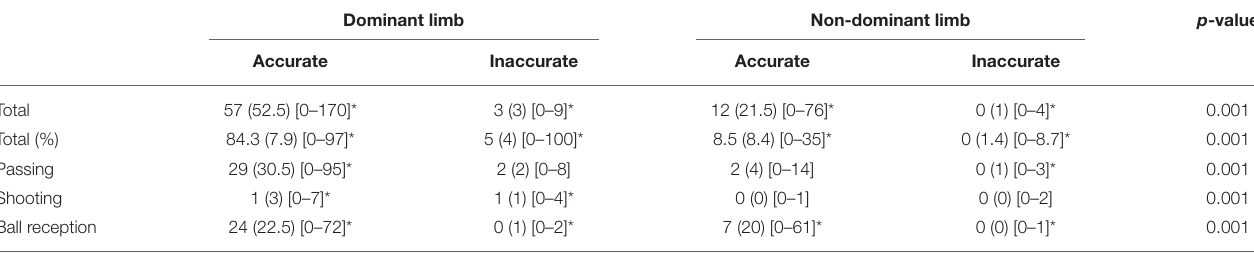
TABLE 1 | Median, interquartile range, and extreme values regarding the frequency counts (i.e., absolute number; a.u.) of technical parameters performed using dominant and non-dominant limb. Dominant limb Non-dominant limb